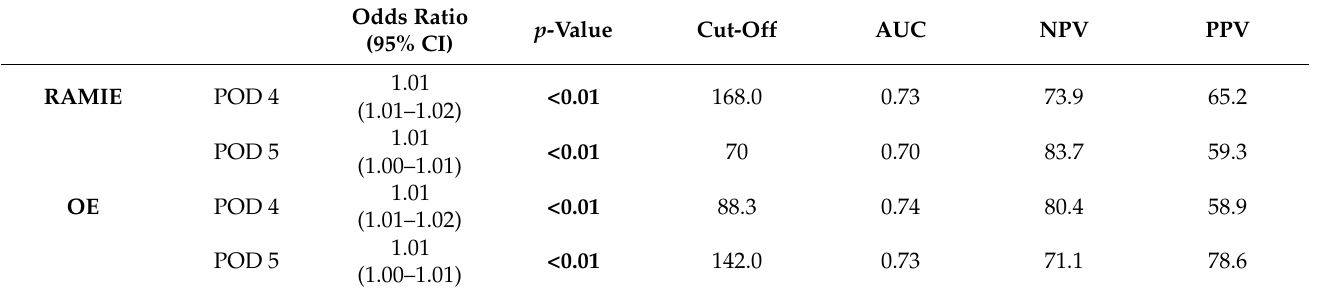
Figure 3. Postoperative CRP-values of patients with PIC ( a ) or without PIC ( b ) stratified by surgical approach. CRP: C-reactive protein, OE: open esophagectomy, POD: postoperative day, RAMIE: ro- bot-assisted minimally invasive esophagectomy, ns: no significance, **: p ≤ 0.01.